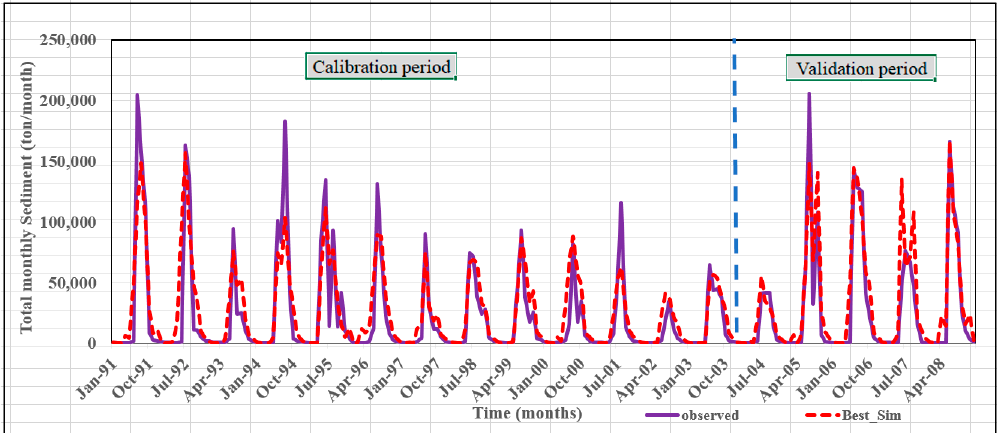
Figure 8. Sediment yield calibration and validation at Merawi gauging station.